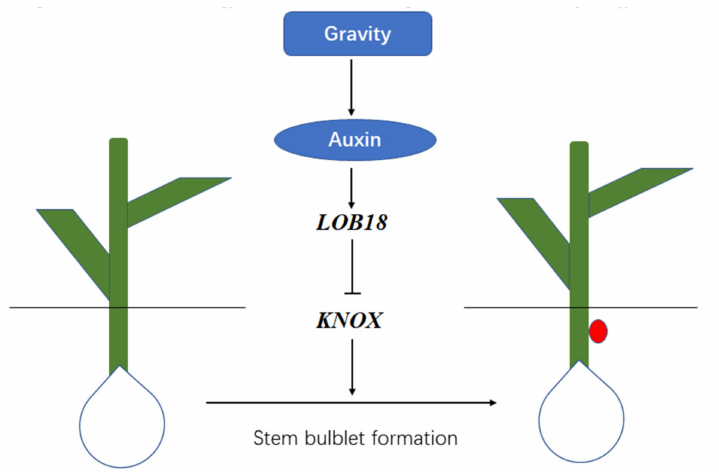
Figure 8. The putative regulatory mechanism of LoLOB18 gene cooperation with auxin signaling under variation of gravity to regulate the underground stem bulblet formation in lily. “ ↓ ” indicates promoted activity and “ ⊥ ” indicates inhibited